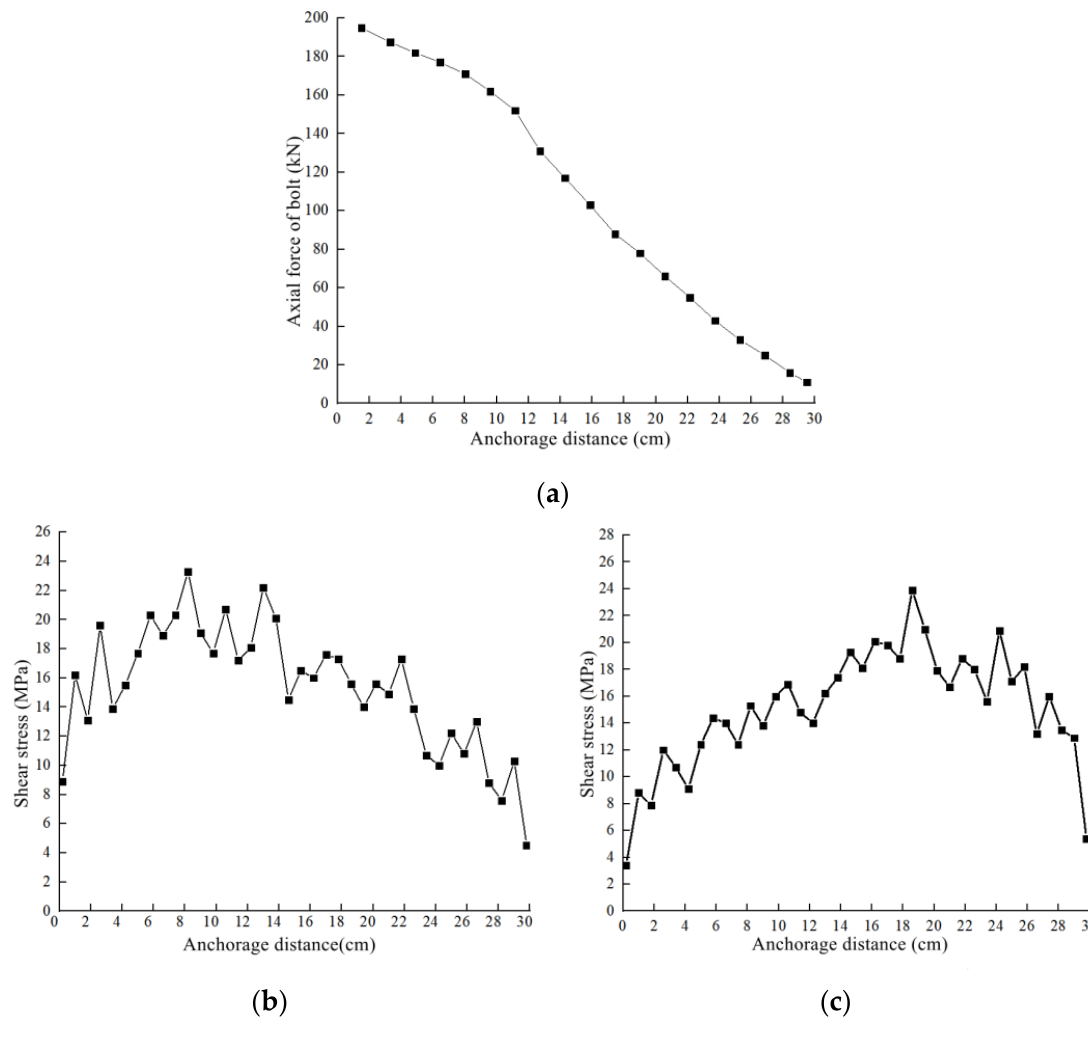
Figure 12. Axial force and interfacial shear stress distribution curve. ( a ) Distribution curve of bolt axial force ( b ) Shear stress curve of I interface ( c ) shear stress curve of II interface.